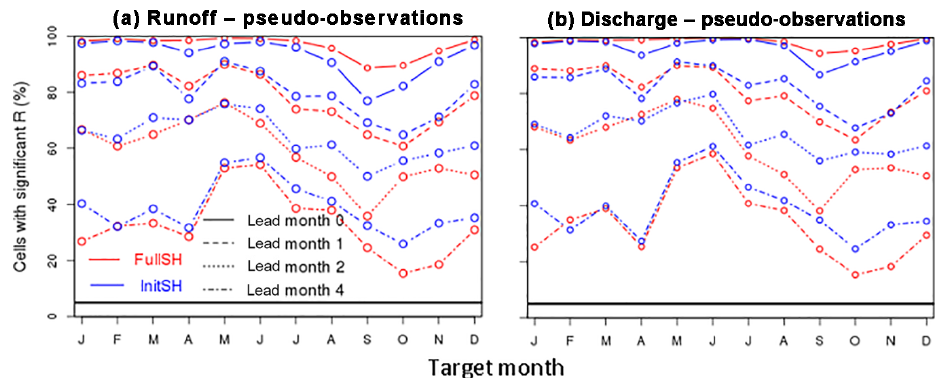
Figure 4. Comparison of the annual cycles of skill of the InitSHs (blue) and the FullSHs (red). The two panels show theoretical skill obtained with the pseudo-observations for run-off (a) and discharge (b) at four different lead times.